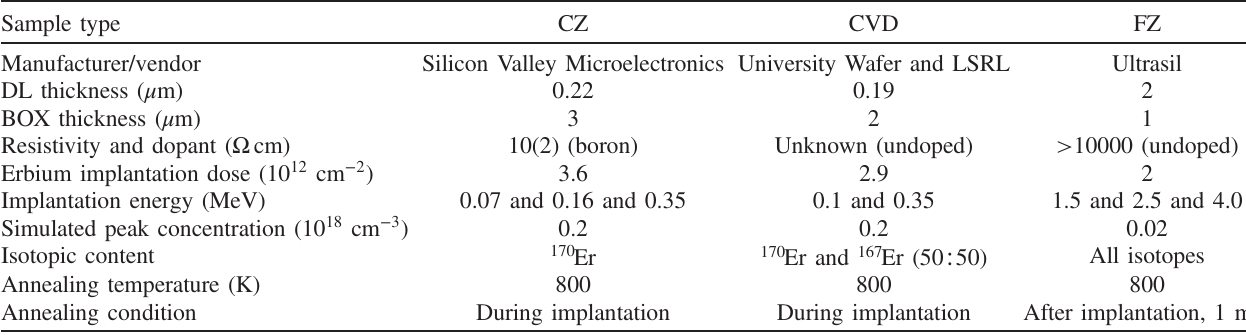
TABLE I. Overview of the geometry and implantation conditions of the three different sample types. Sample